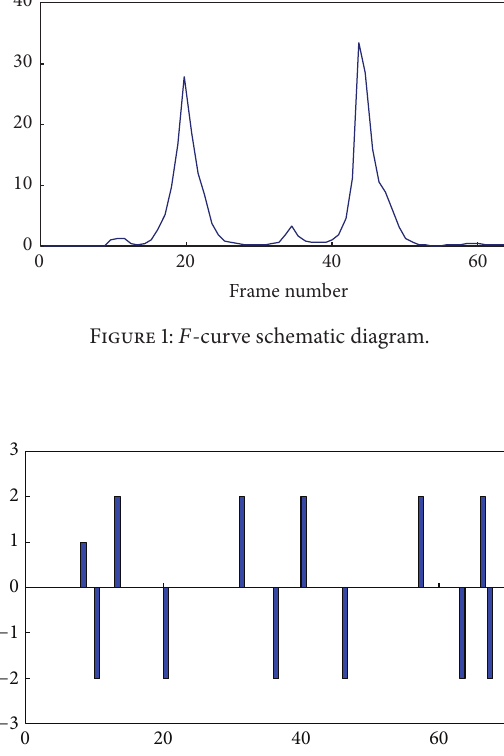
Figure 2: Local-maximum of 𝐹